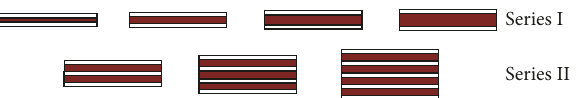
Figure 18: Two series of area density